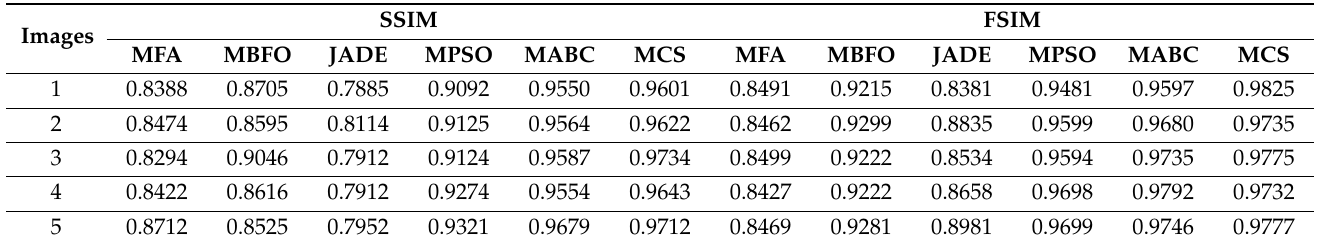
Table 9. SSIM and FSIM using different optimization algorithms with the GLCM